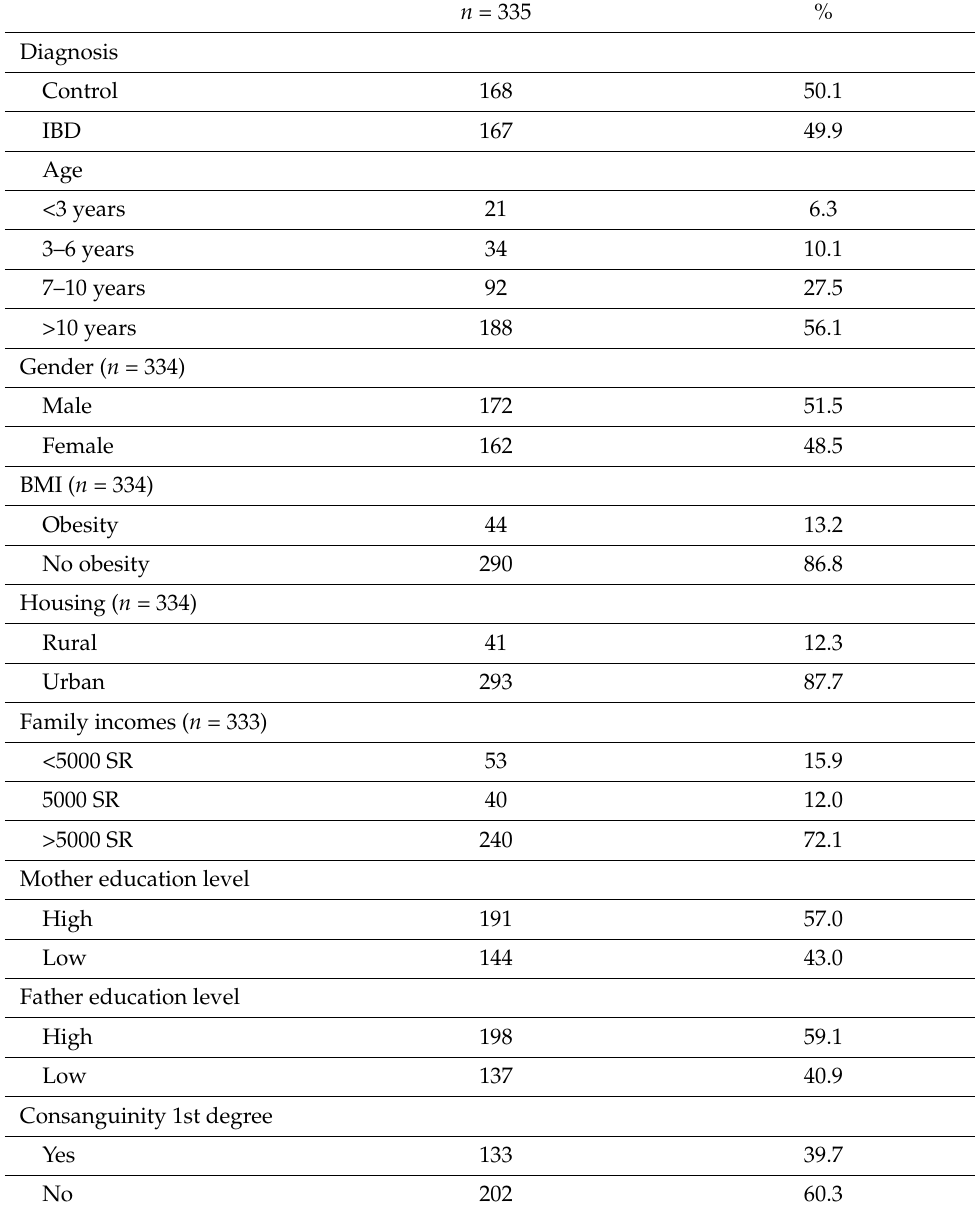
Table 1. Demographic and characteristics of the study